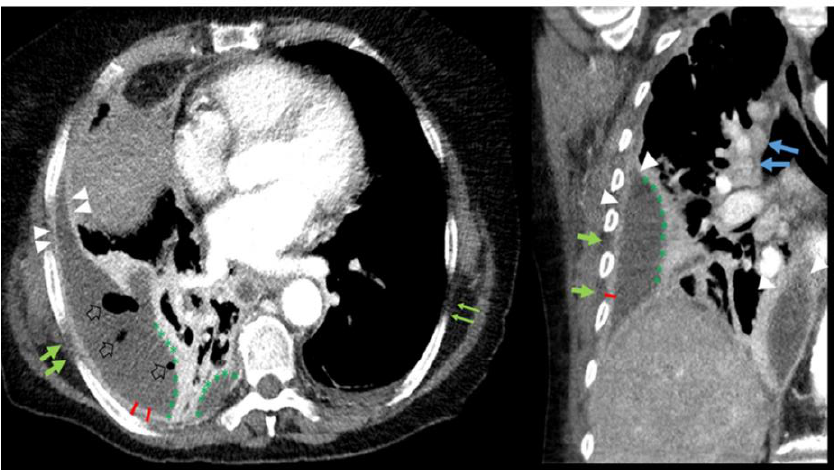
Figure 1. Axial ( right ) and coronal ( left ) reconstruction of a 73-year-old patient with empyema on the right side. The arrowheads show increased pleural enhancement of the parietal (costal and mediastinal) and visceral (lung) pleura, consistent with a “split pleura sign” associated with pleural thickening (red dash). Pleural fat stranding (bold green arrows, compared to the normal contralateral side, thin green arrows) and microbubbles (empty arrows) are also present. Pleural empyema on the right side is loculated (green *) in contrast to the simple pleural effusion on the contralateral side. There is reactive hilar and mediastinal lymphadenopathy (blue